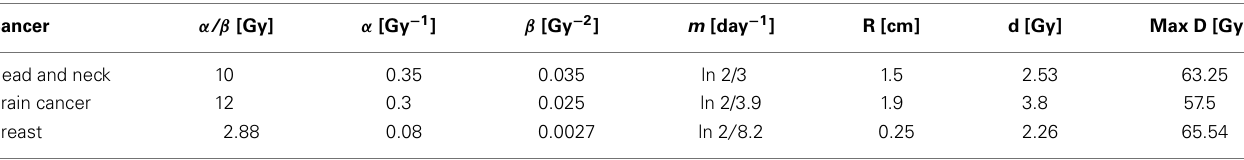
Table 1 | Summary of model parameters for the three cancers studied here.